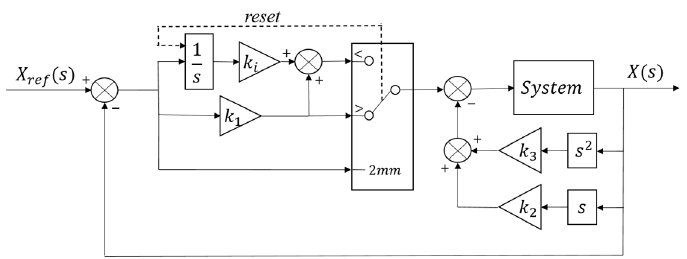
Figure 7. Block diagram of the SFC+I controller. Table 3. SFC+I controller performance metrics.